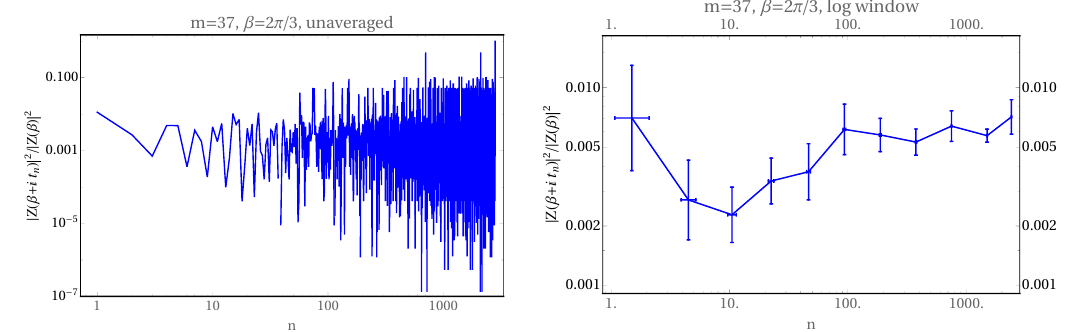
Figure 8 . Left: the spectral form factor of the m = 37, k = 1 model at integer-spaced times t n = 2 (cid:25)n without averaging. Right: the same plot averaging over a log window of t . The error bar of each point is the standard deviation of the mean. At these values of m , which are the largest we are able to compute exactly, it is still unclear what the large m behavior of the function